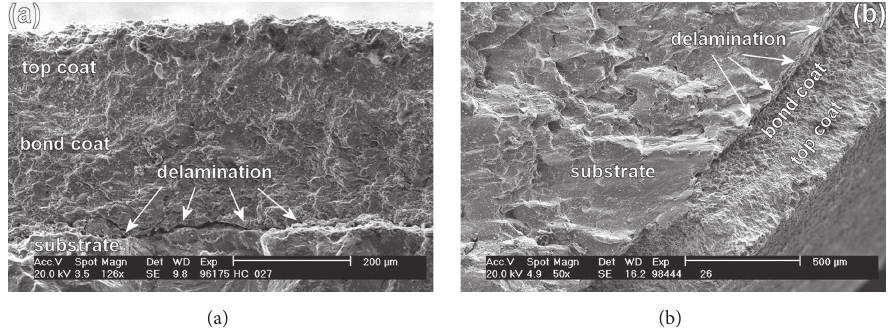
Figure 7: Initiation sites in specimens with thermal barrier coatings subjected to (a) bending ( 𝑍 = 0 , 𝑁 𝑓 = 2.7×10 4 cycles) and (b) combined bending-torsion ( 𝑍 = 0.64 , 𝑁 𝑓 = 4.2 × 10 4 cycles) loading.